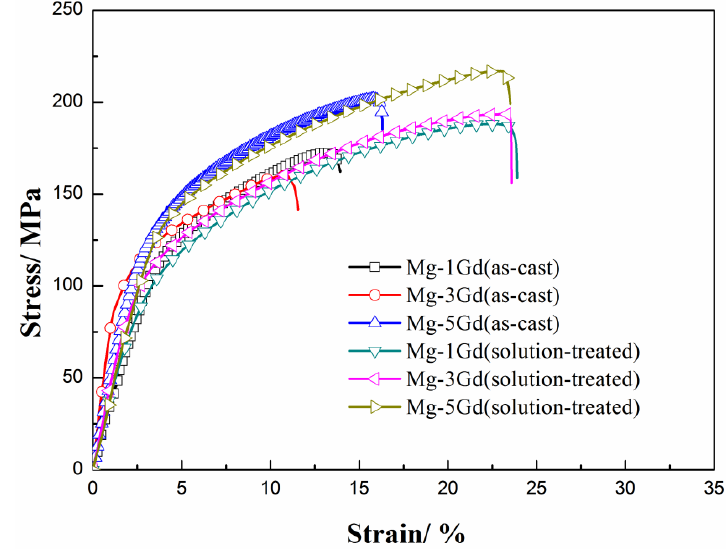
Figure 5. The XRD pattern of Mg-xGd alloys after solution treatment.